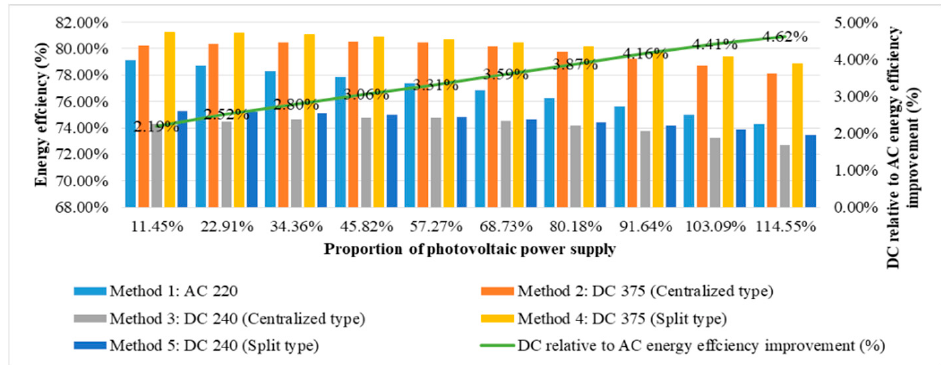
Figure 16. The relationship between the proportion of photovoltaic power generation and the improvement of DC–AC energy efficiency.